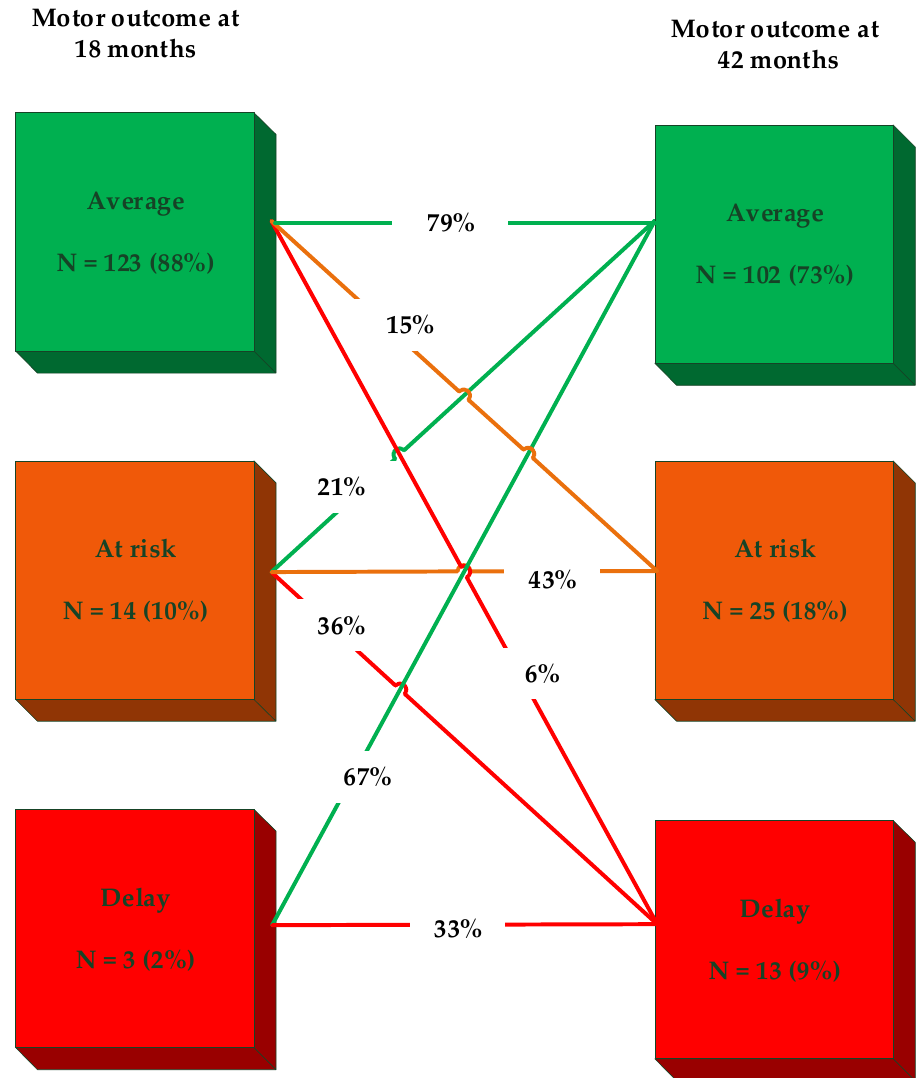
Figure 3. Longitudinal motor development between 18 and 42 months. Scores above the 16th percentile are classified as ‘average’ motor performance. Scores between the 6th and 16th percentile are classified ‘at risk’ for motor difficulties. Scores at or below the 5th percentile indicate a motor ‘delay’.